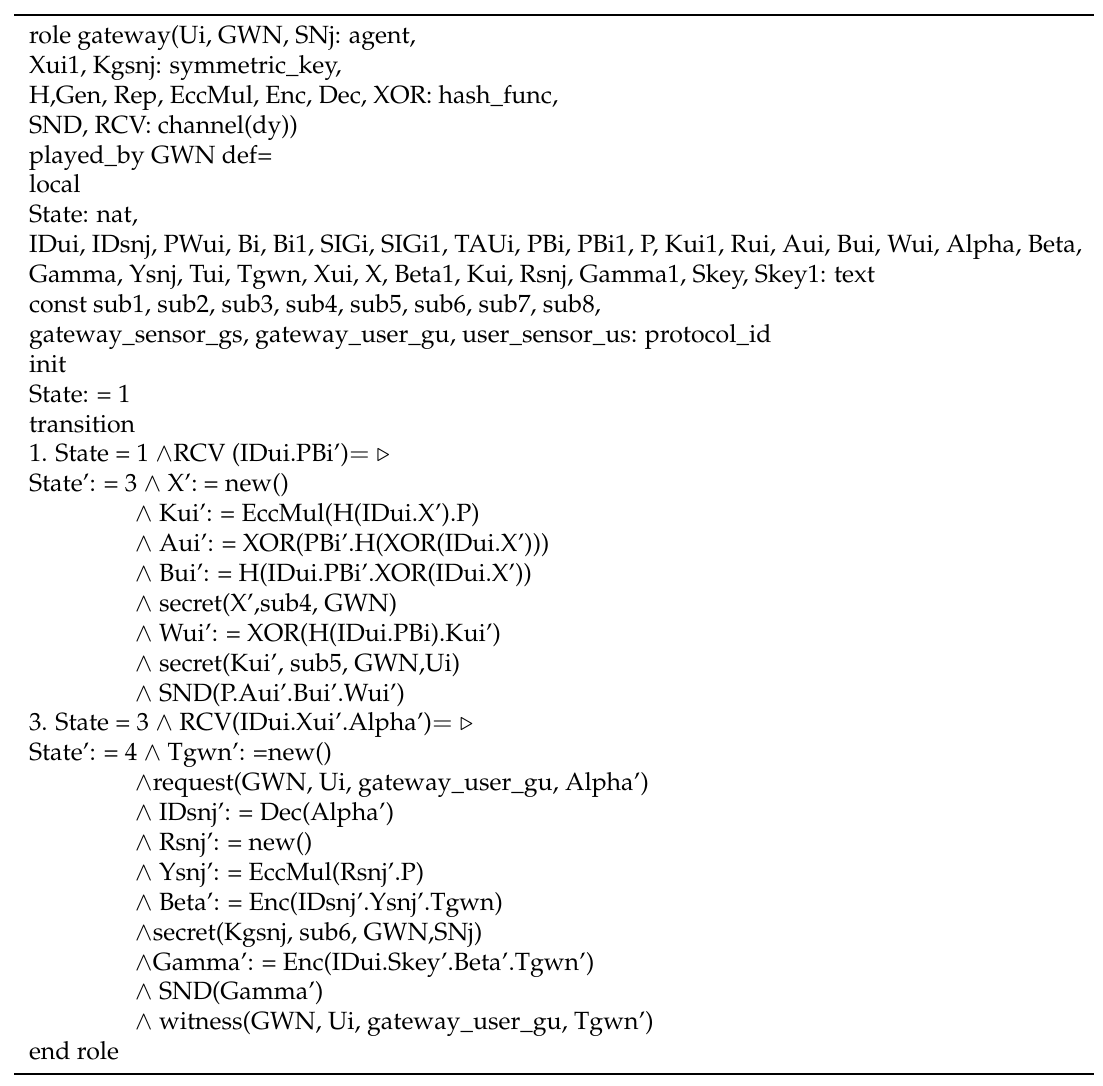
Table 15. Specification of GWN ’s role in